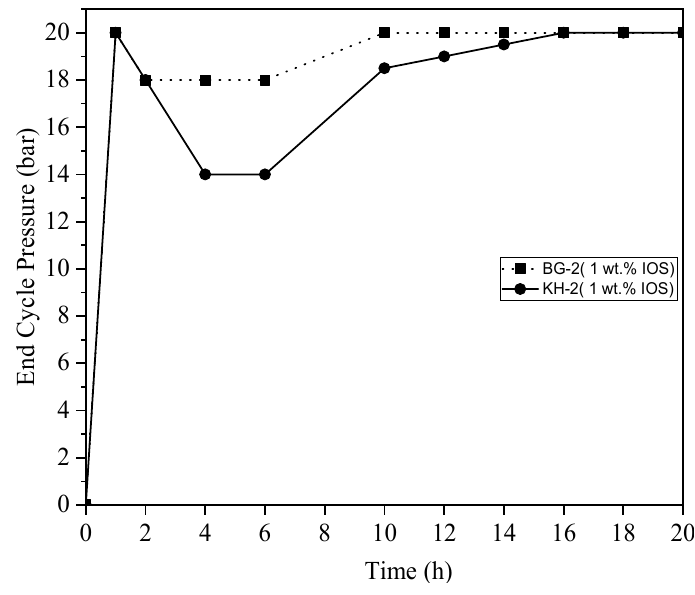
Figure 12. The end cycle adsorption pressure for BG-2 and KH-2 shales treated with IOS